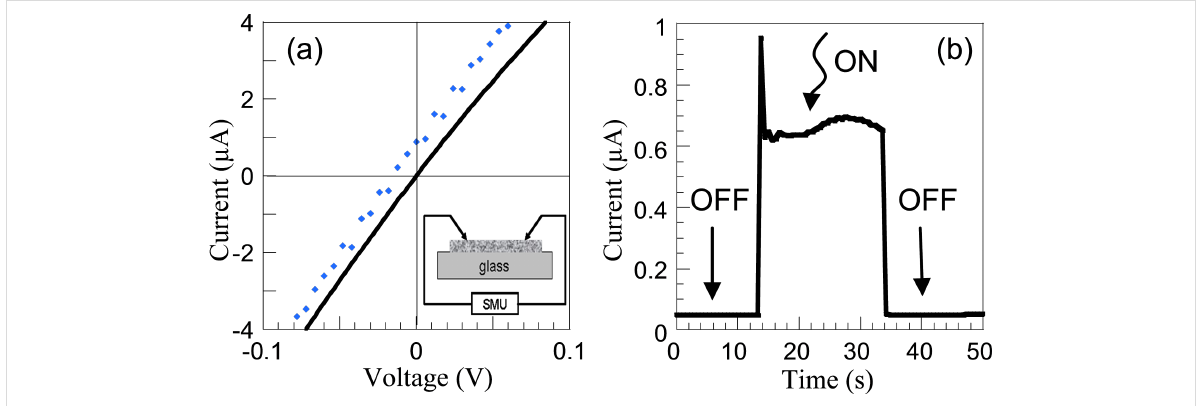
Figure 5: (a) I – V characteristic of a nanohybrid material in the dark (full line) and under illumination (dots) vs bias voltage. In the inset, a schematic illustration of the measurement set up is given. (b) On/off cycle photoresponse of MWCNT:HfO 2 excited with UV–vis light (at 10 mV).